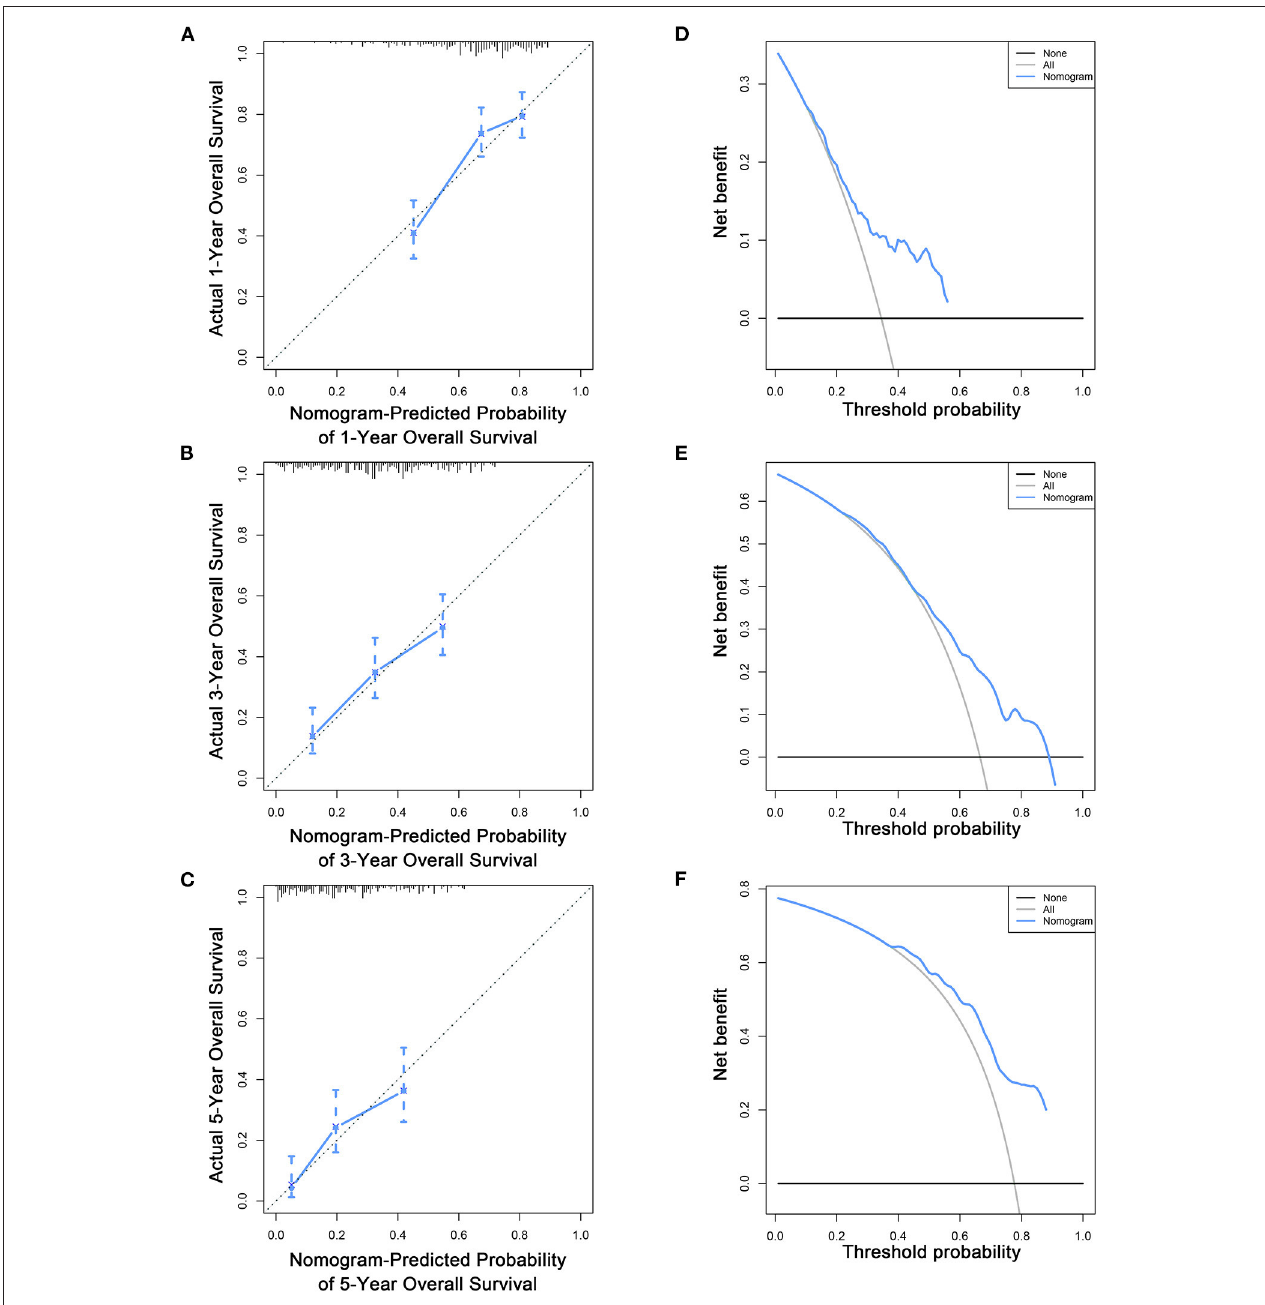
FIGURE 7 | Calibration curves (A–C) and DCA (D–F) of the nomogram for predicting patients’ OS at 1, 3, and 5 years in the validation